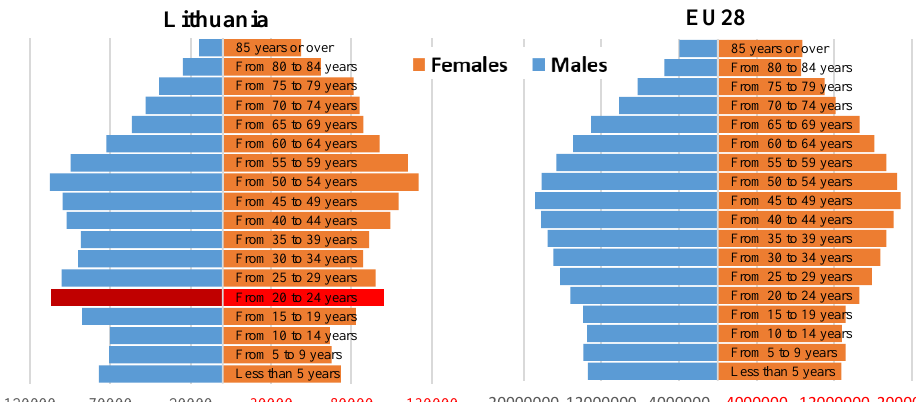
Fig. 2. Population pyramids of Lithuania and EU28 as of 1 January 2015 (authors’ elaboration based on Eurostat data).